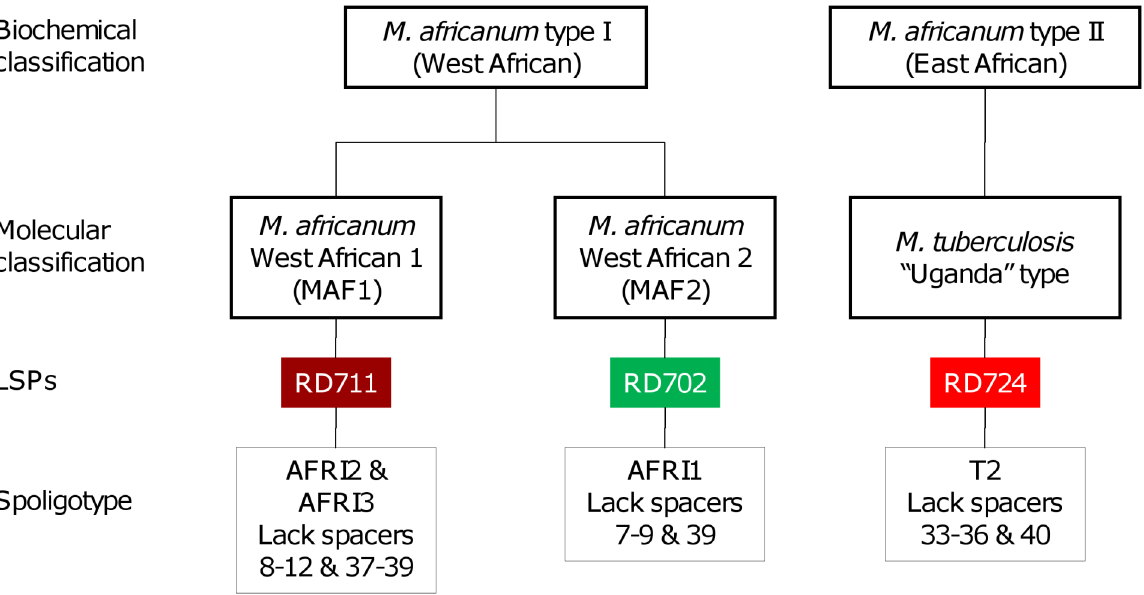
Figure 1. Nomenclature of M.africanum as related to its biochemical and molecular classification. Biochemical classification is reviewed in Table 1. LSPs, large sequence polymorphisms [5]. Spoligotype signatures are reviewed in [16].